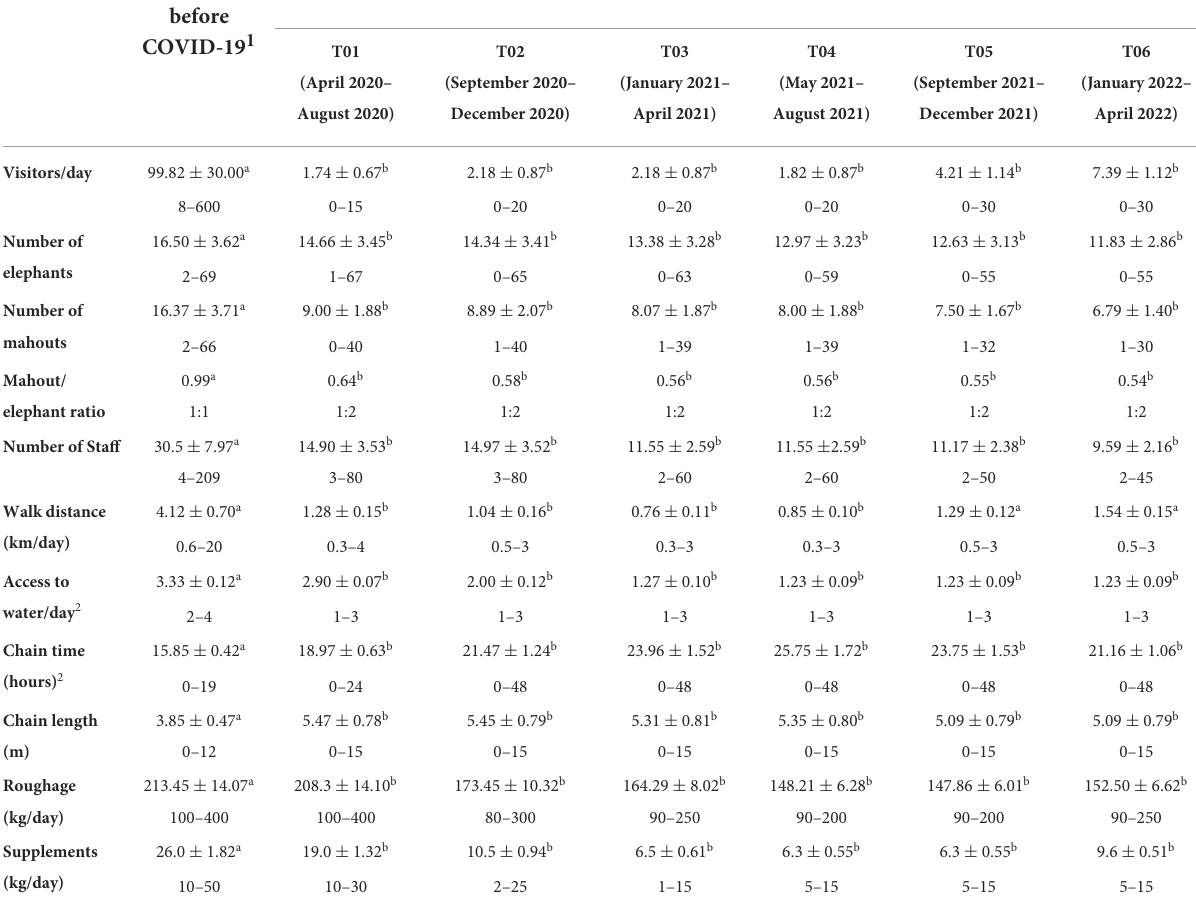
TABLE 1 Summary of parameters (mean ± SEM, range) related to management of elephants in tourist camps in Chiang Mai province, Thailand, in each period from surveys conducted over 2 years during the COVID-19 pandemic compared to the year pre-COVID-19.